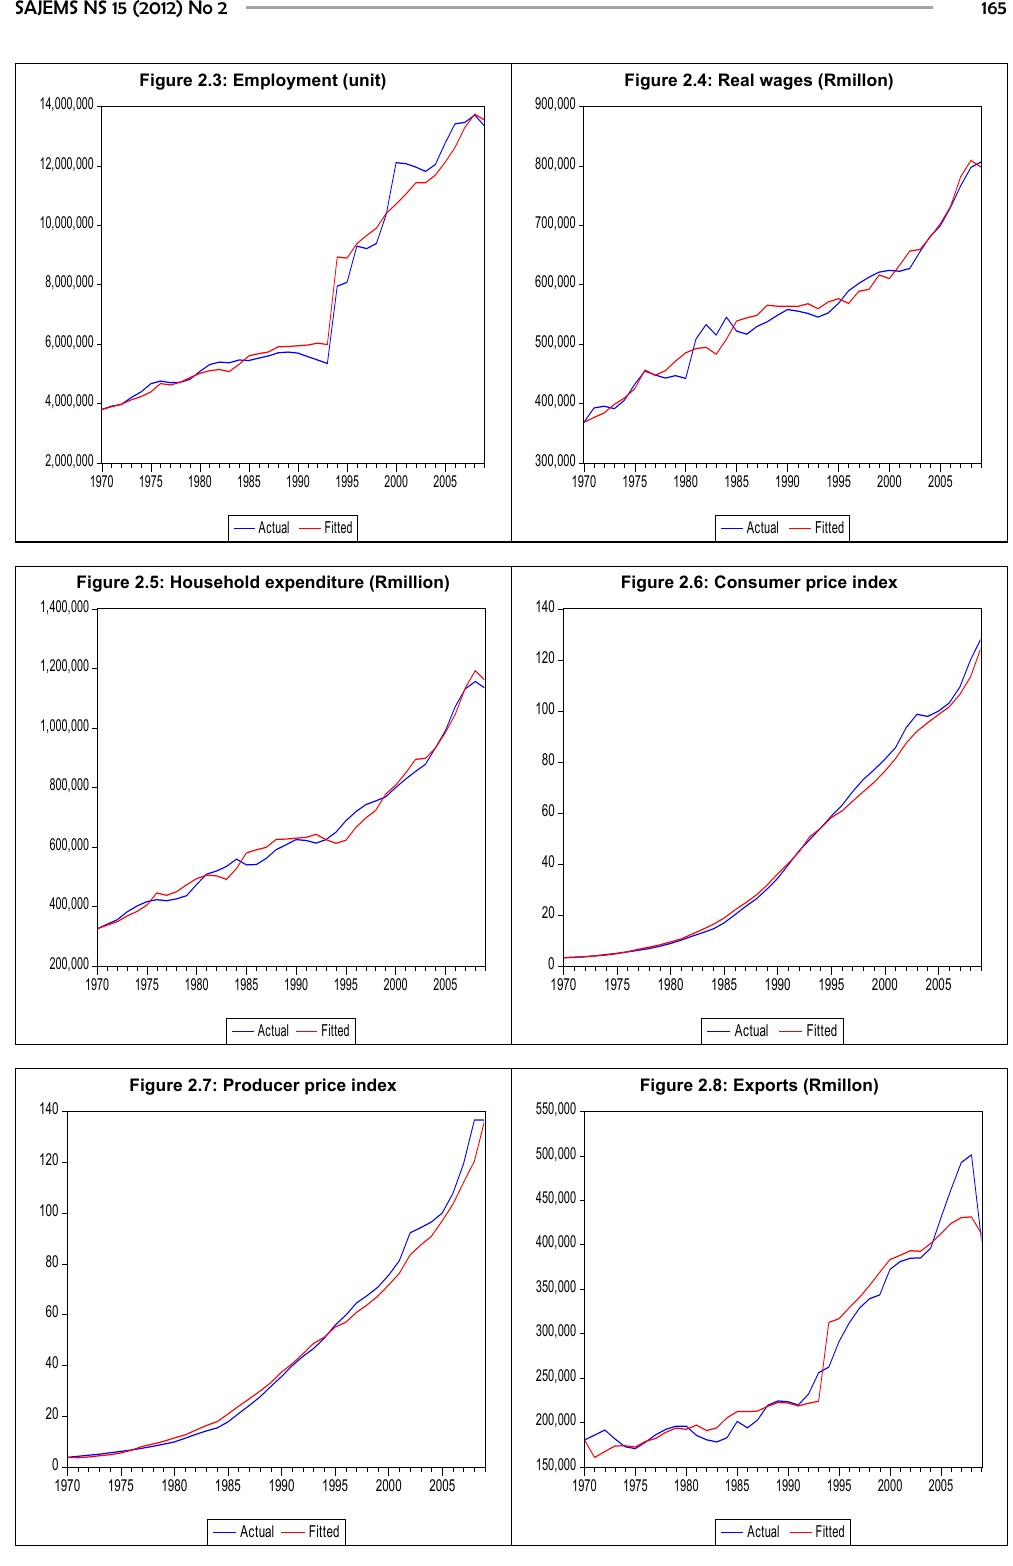
Figure 2.7: Producer price index Figure 2.8: Exports